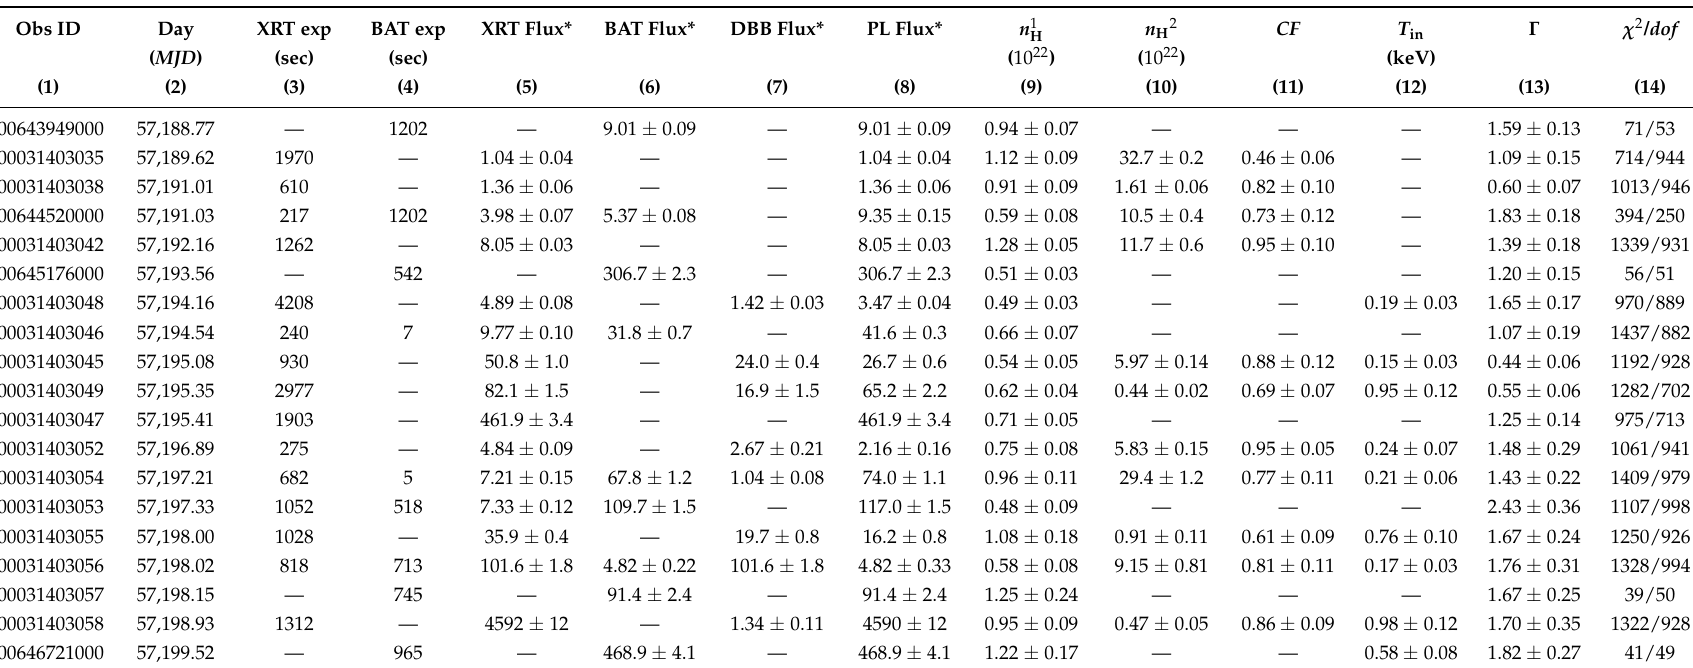
Table 1. DBB+PL Model Fitted Spectral Analysis